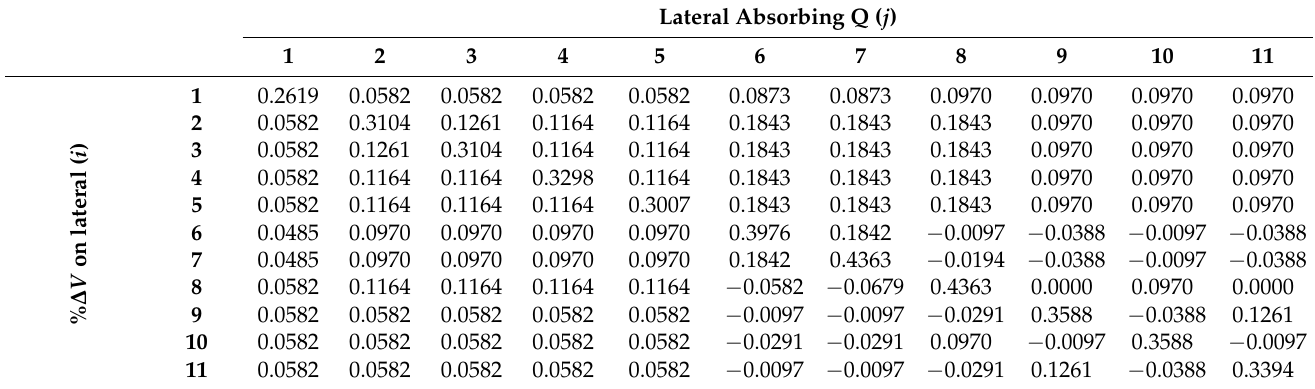
Table 3. Voltage sensitivity to change in reactive power (maximum change for three-phase laterals).